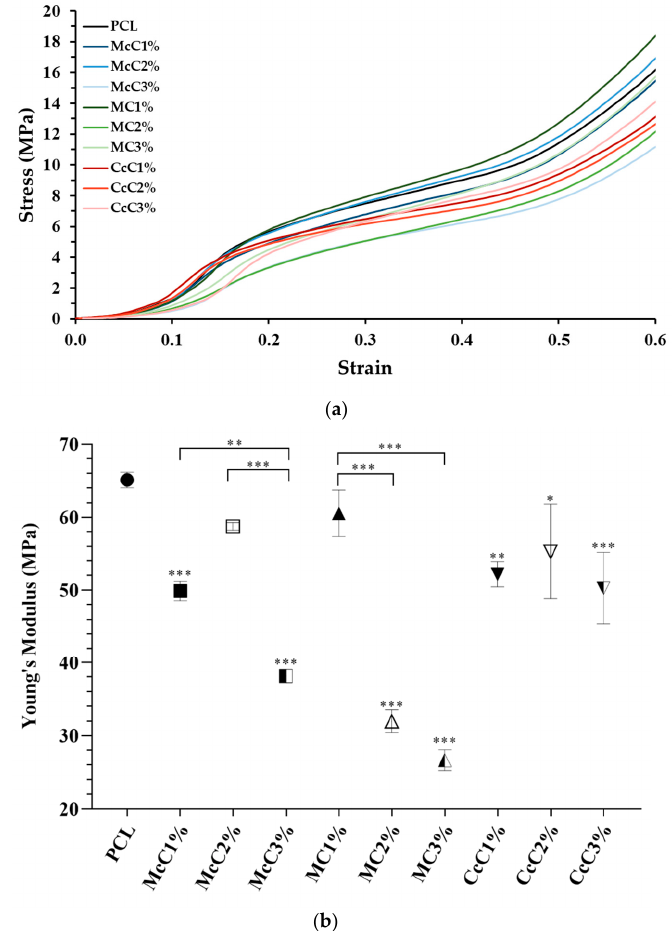
Figure 3. Mechanical performance of scaffolds upon compression: ( a ) Mean curves; ( b ) Compressive modulus (Mean ± SD, n = 3). Statistically significant differences are presented as: * p < 0.05; ** p < 0.01; *** p < 0.001.